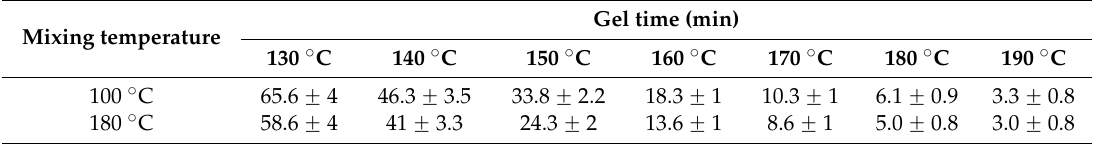
Table 1. Comparison of gel times for two mixing temperatures.